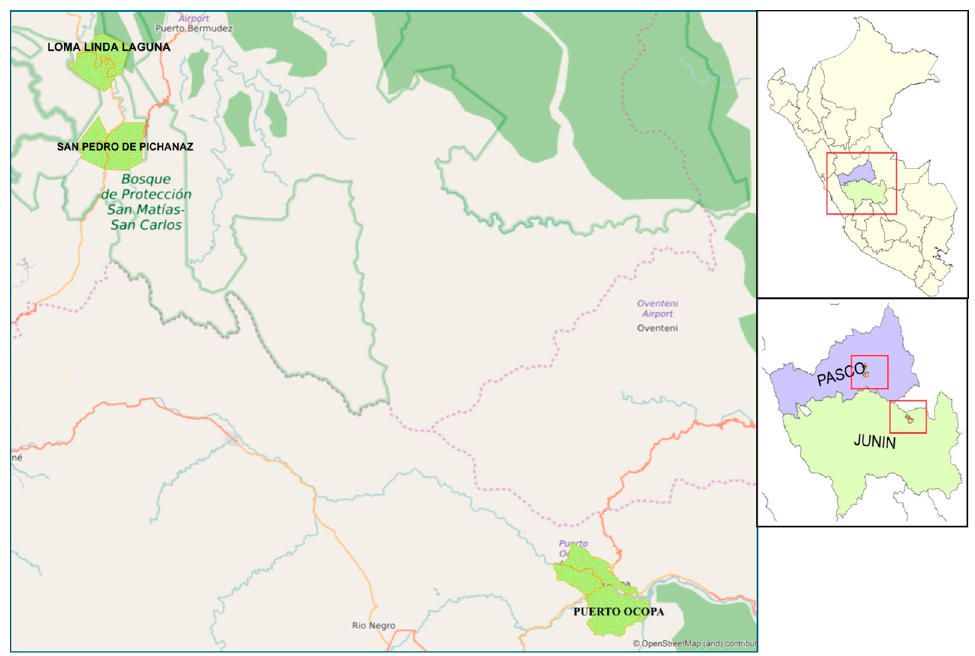
Figure 1. Study area of three communities: Puerto Ocopa, Loma Linda Laguna, and San Pedro de Pichanaz, located the regions of Junín and Pasco, central Peruvian Amazon.